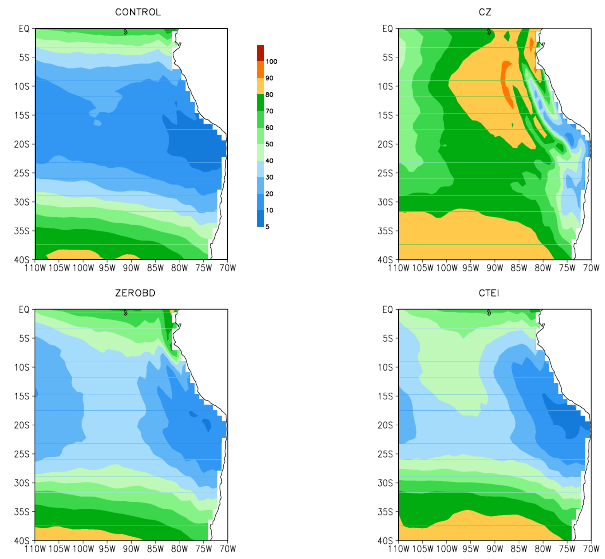
Fig. 1. The ensemble July 2008 mean total cloud cover in the SEP region in all four